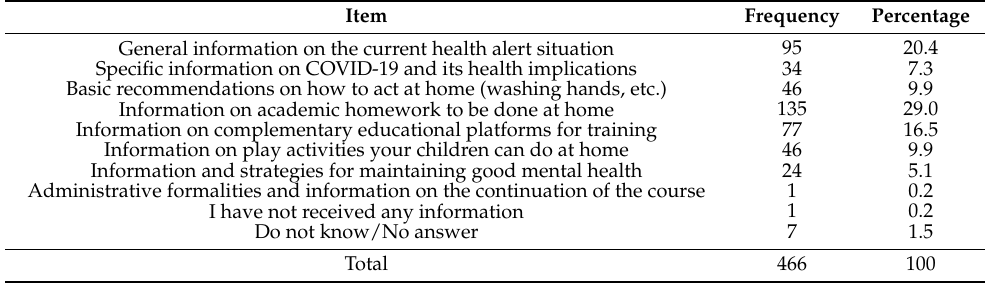
Table 4. Types of information provided by schools to families related to the health